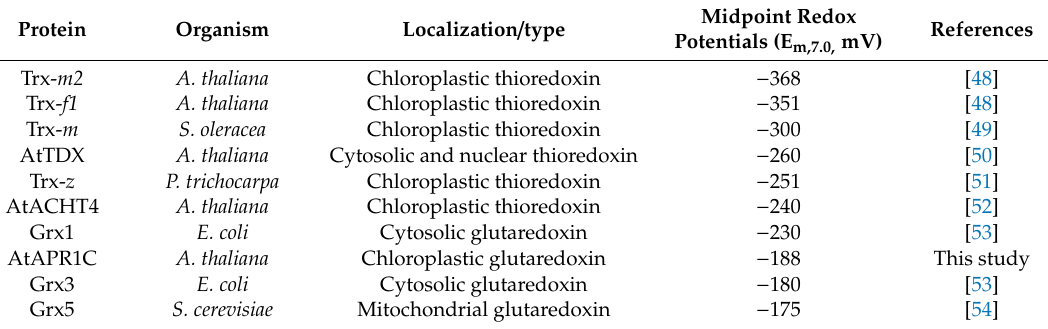
Table 3. Midpoint redox potentials of AtAPR1 redox domain and several reported thioredoxins and glutaredoxins.